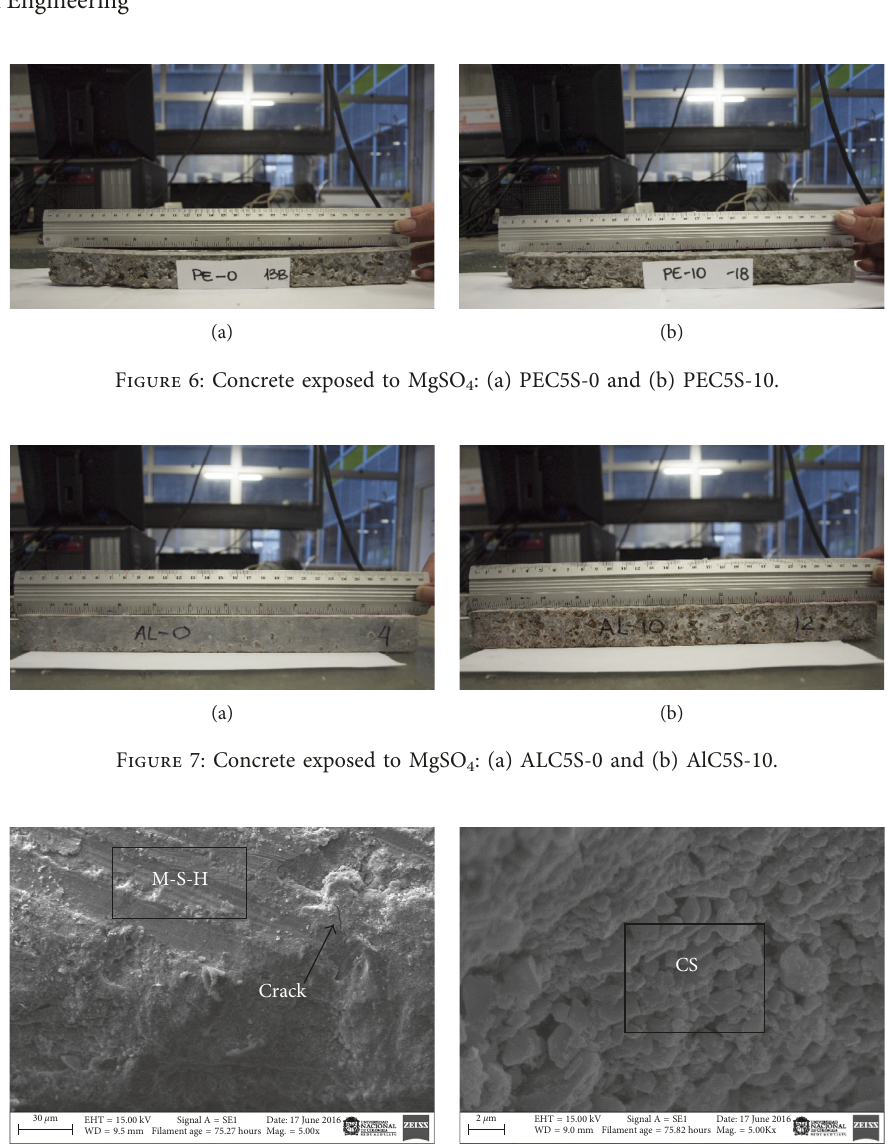
Figure 8: Border to the specimen of (a) ALC5S-0 and (b)